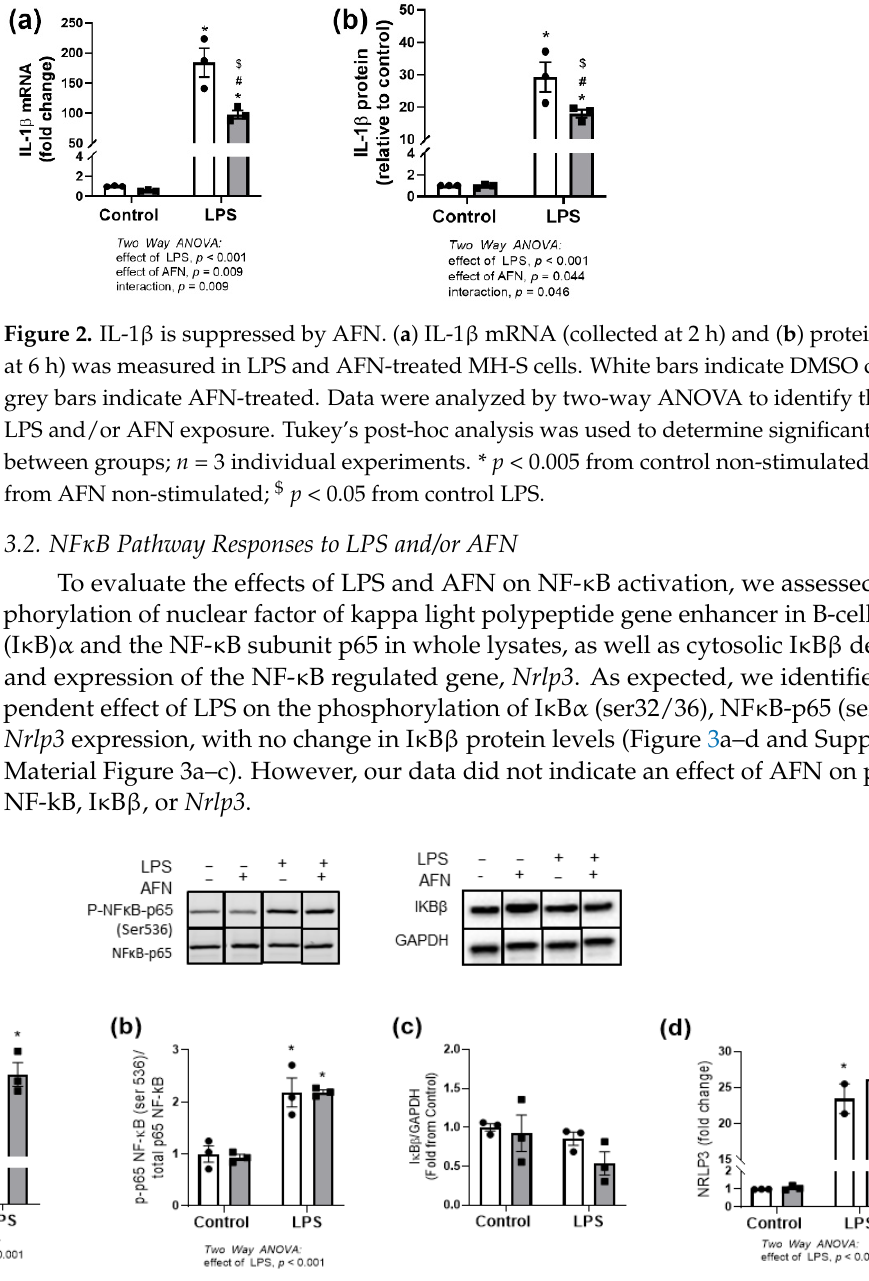
Figure 3. NF κ B pathway is not affected by AFN. Protein levels of ( a ) p-I κ B α , ( b ) p-p65 NF κ B, and ( c ) total IkB β were measured by immunoblot in LPS and AFN-treated MH-S cells at 1 h after treatment. ( d ) mRNA expression of NRLP3 was measured by RT-PCR 2 h after treatment and expressed as fold change. White bars indicate DMSO control, and grey bars indicate AFN-treated. Data were analyzed by two-way ANOVA to identify the effects of LPS and/or AFN exposure. Tukey’s post-hoc analysis was used to determine significant differences between groups; n = 3 individual experiments. * p < 0.005 from control non-stimulated.